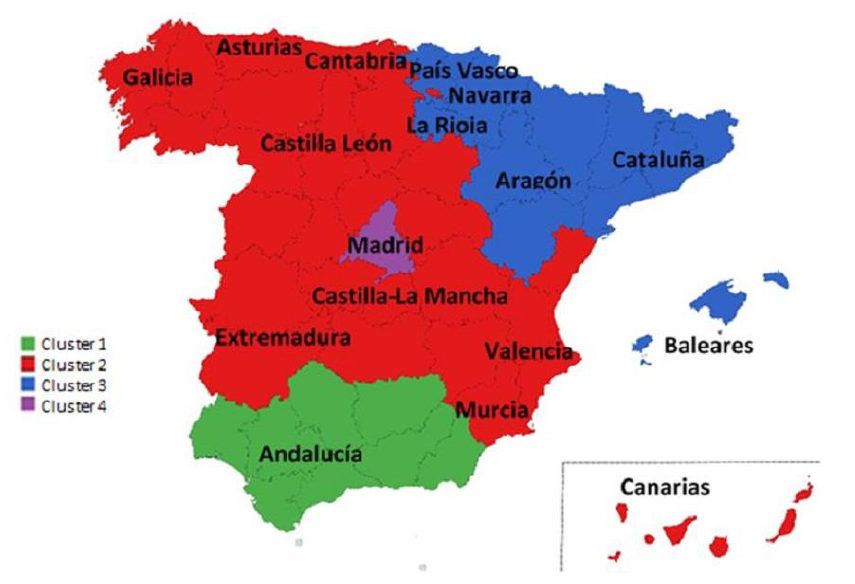
Figure 3. Cluster map.